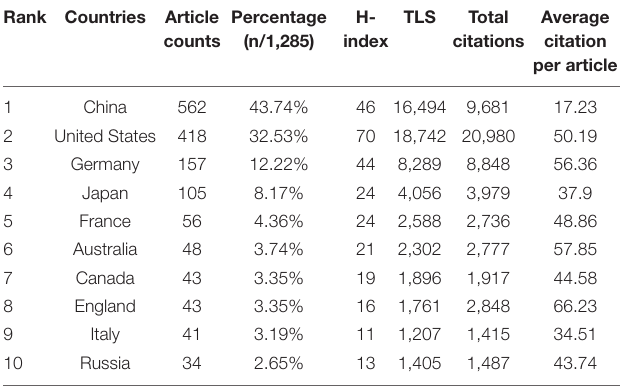
TABLE 1 | The top 10 productive countries with publications concerning ferroptosis.